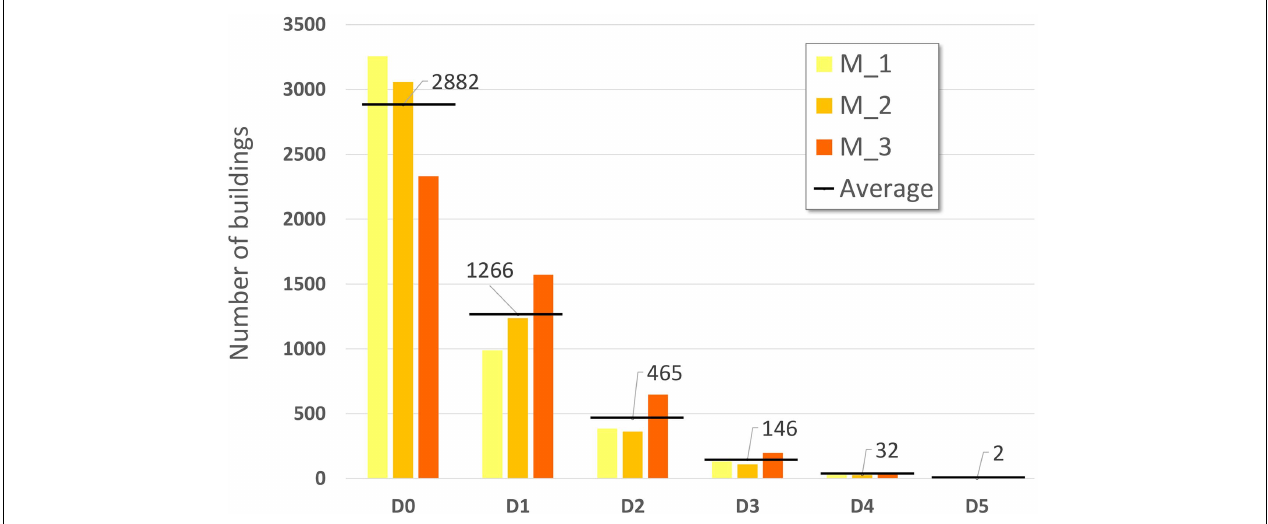
FIGURE 7 | Damage distribution obtained through the methods M_1 (Bernardini et al., 2007), M_2 (Lagomarsino and Giovinazzi, 2006), and M_3 (Di Pasquale et al., 2005). Black line indicates the average number of buildings in each damage class.